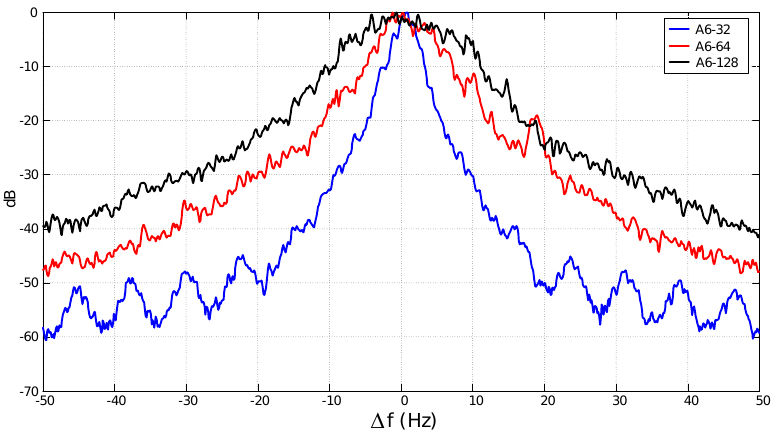
Figure 4. Normalized Doppler spectrum in Channels A6-32, A6-64 and